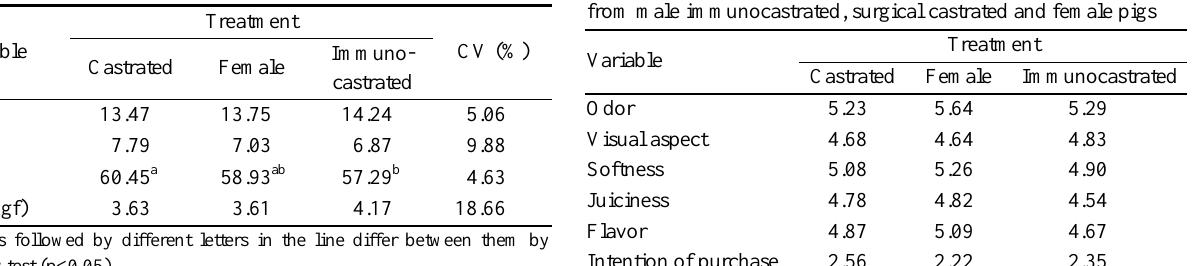
Tukey test (p<0.05).